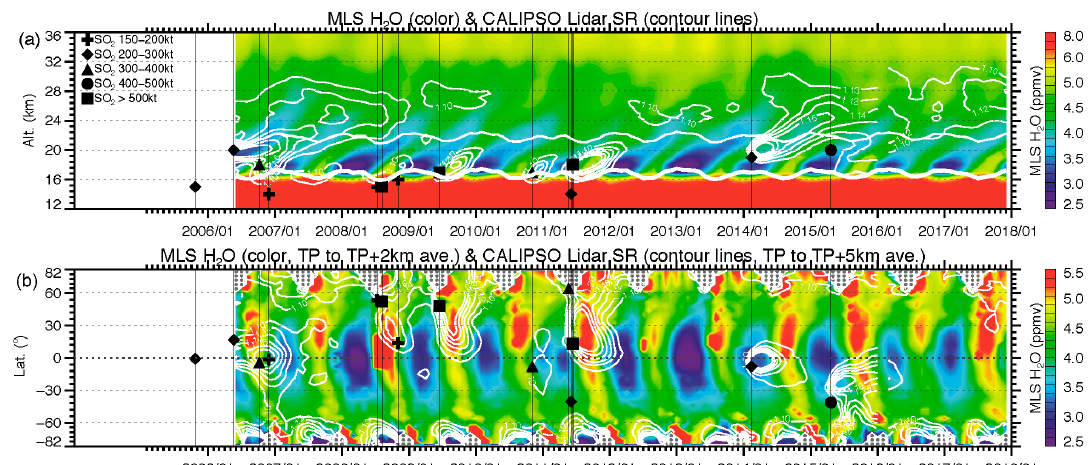
Figure 12. Time series of MLS H2O and CALIOP SR for ( a ) the tropics (20 ◦ S–20 ◦ N) and ( b ) the layer F igure 12. Time series of MLS H2O and CALIOP SR for ( a ) the tropics (20°S–20°N) and ( b ) the layer between TP and between TP and TP+2km.